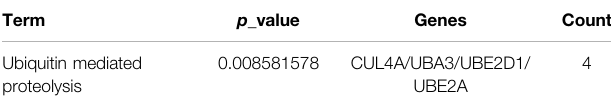
TABLE 7 | KEGG enrichment analysis of downregulated